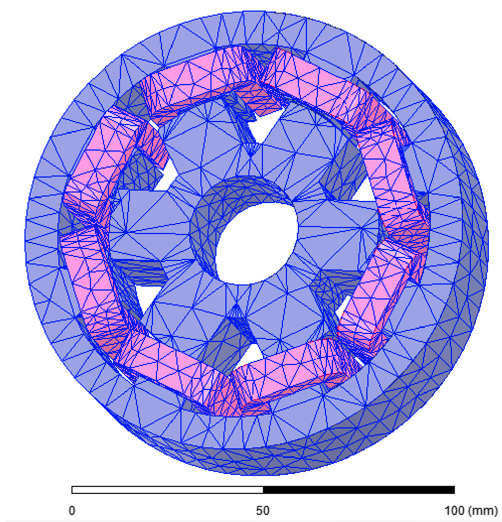
Figure 3. 3D geometry and mesh of the switched reluctance motor.